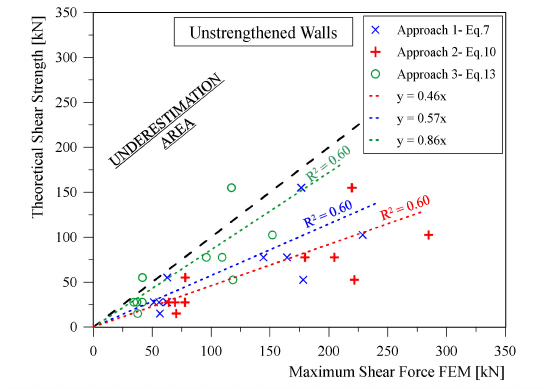
Figure 3. Theoretical shear force vs. Finite Element Model (FEM) predictions for un-strengthened